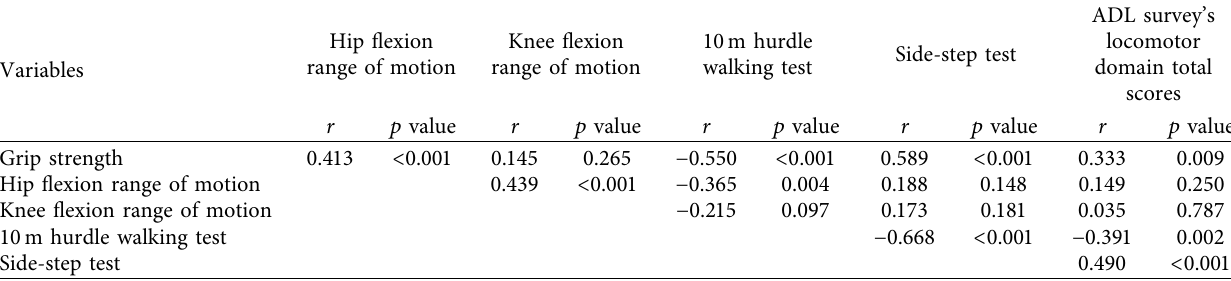
Table 3: Pearson correlations between variables in older men ( n �